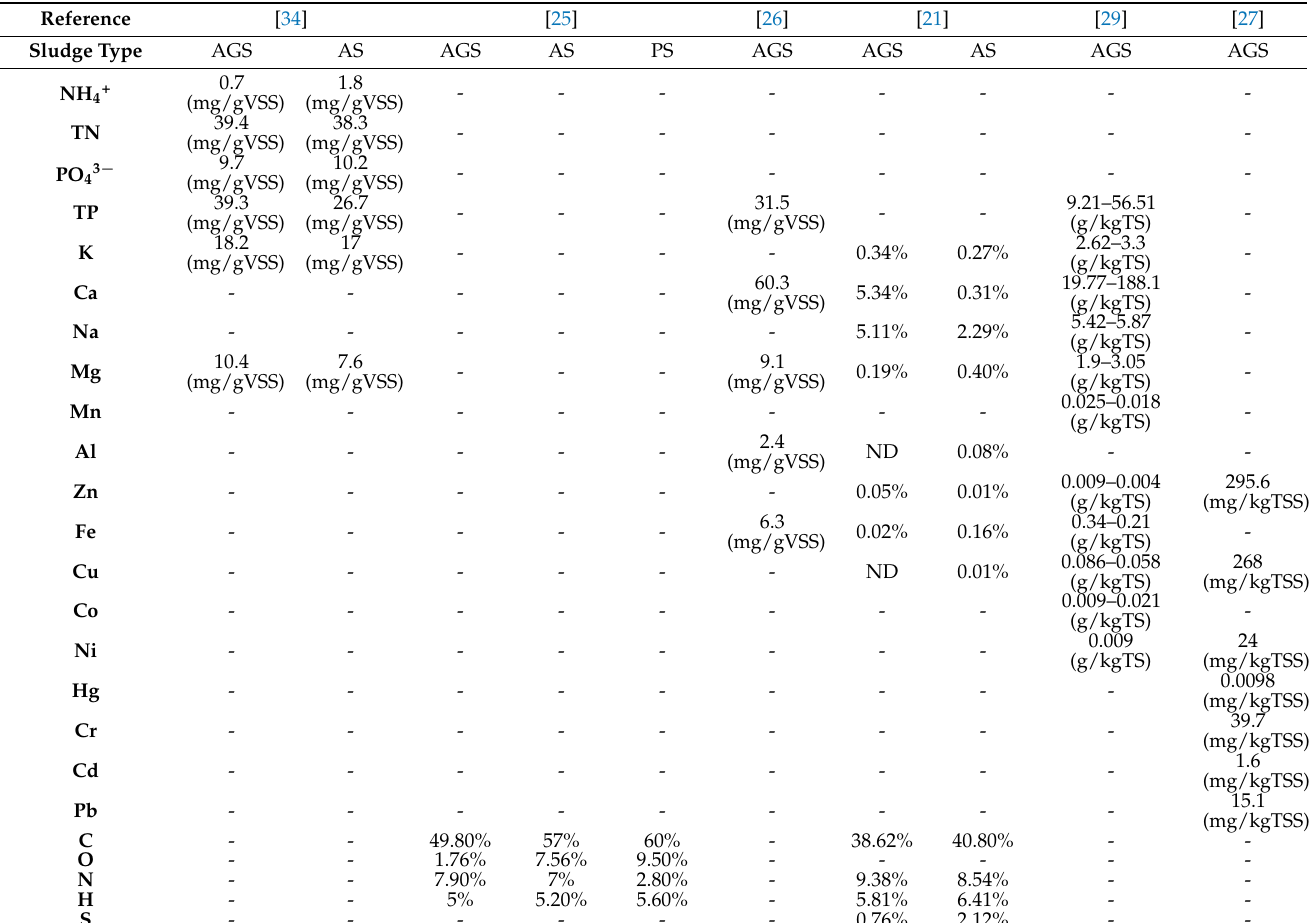
Table 4. Inorganic composition of AGS and AS from different